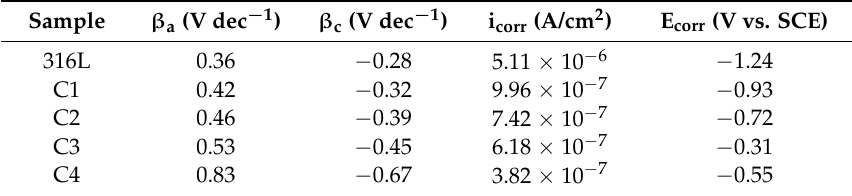
Figure 6. The polarization curves of 316L substrate and CrN films. Table 4. The anodic slope ( β a ), cathodic slope ( β c ), corrosion current density (i corr ) and corrosion potential (E corr ) of 316L substrate and CrN films in seawater.